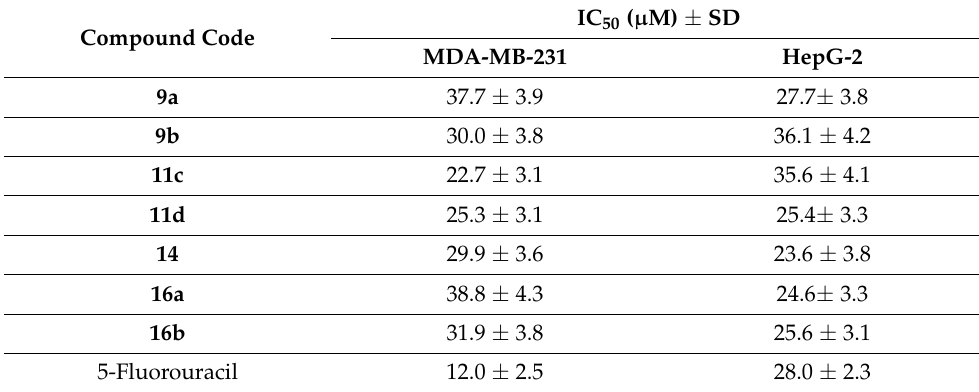
Table 1. IC 50 of the examined compounds on two different cancer